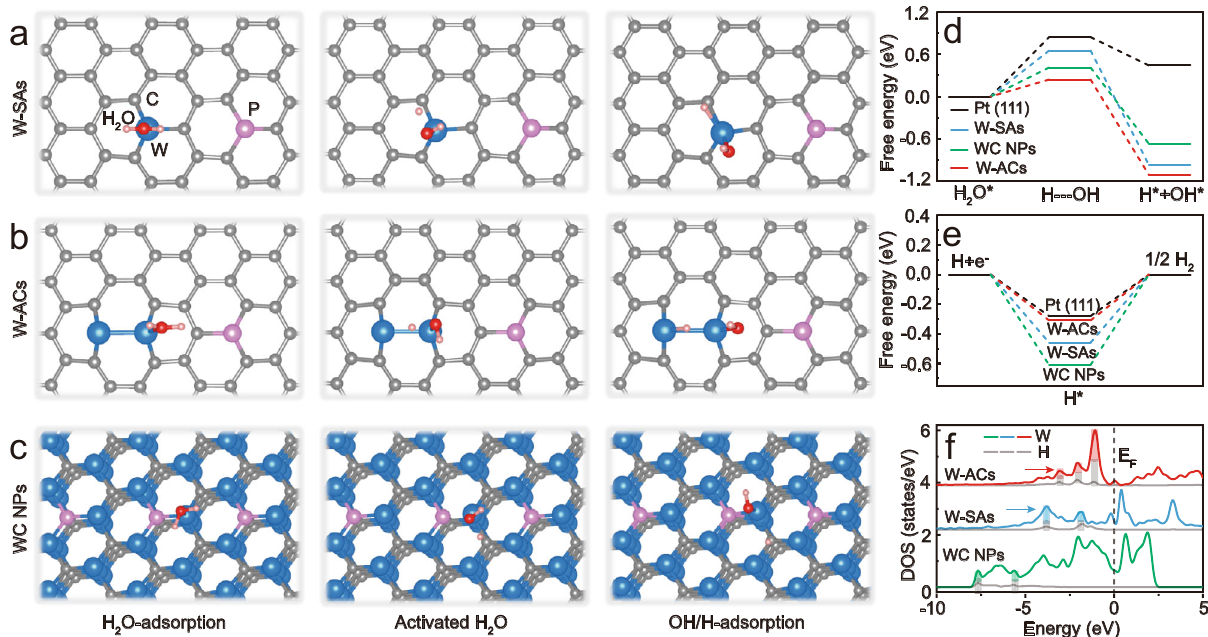
Fig. 5 Proposed reaction mechanism of the alkaline HER electrocatalysis over the W-AC catalyst. DFT calculated adsorption models for H 2 O and activated H 2 O, OH - , and H + on the surface of ( a ) W-SAs, ( b ) W-ACs and ( c ) WC NPs. Here, H, C, O, P, and W atoms are indicated by orange, gray, red, pink, and blue spheres, respectively. The corresponding calculated free energy diagrams for ( d ) water dissociation and ( e ) hydrogen desorption steps on the reference Pt (111), W-SAs, W-ACs, and WC NPs. f Local density of states for the W and H atoms on the surface of W-SAs, W-ACs, and WC NPs. The shaded marked positions indicate the interaction energy of W-H